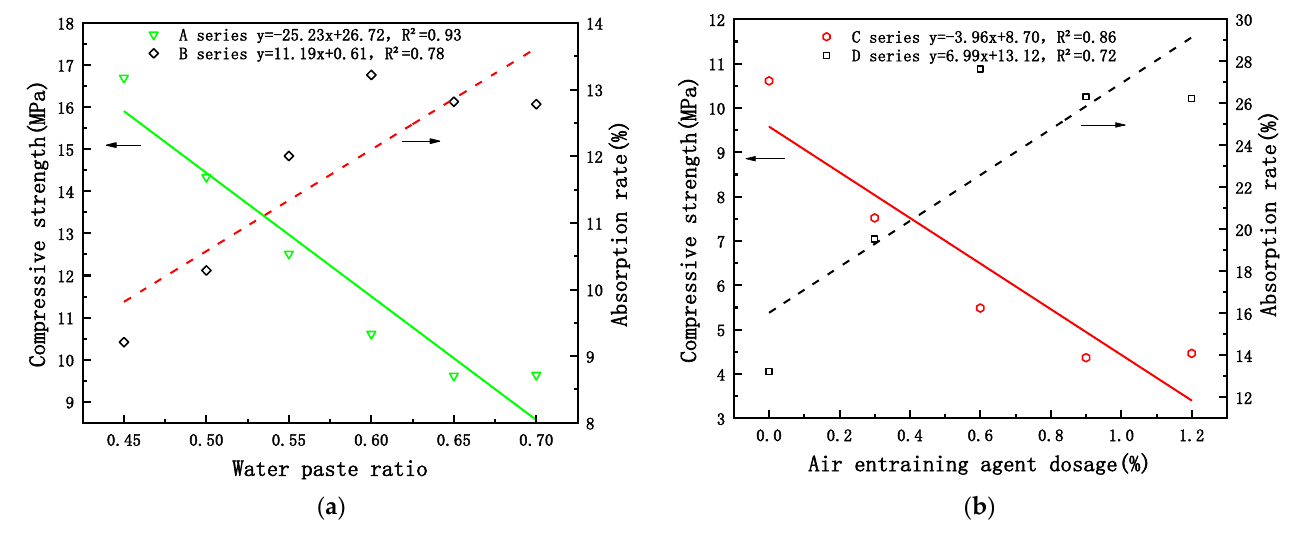
Figure 2. Relationship between the single factors and the absolute dry compressive strength and adsorption rate of phosphorous gypsum: ( a ) water – gypsum ratio; ( b ) air-entraining agent. In the 0.5 – 0.60 range, the water – paste ratio was inversely proportional to the com- pressive strength and directly proportional to the absorption rate. The corresponding compressive strength was 14.34–10.61 MPa, and the corresponding absorption rate was 10.29–13.22%. Figure 2b depicts the relationship of the air-entraining agent, compressive